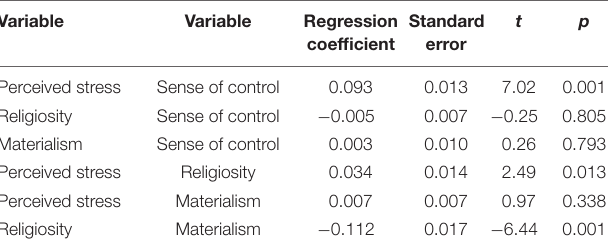
TABLE 3 | Estimated covariance in the recursive